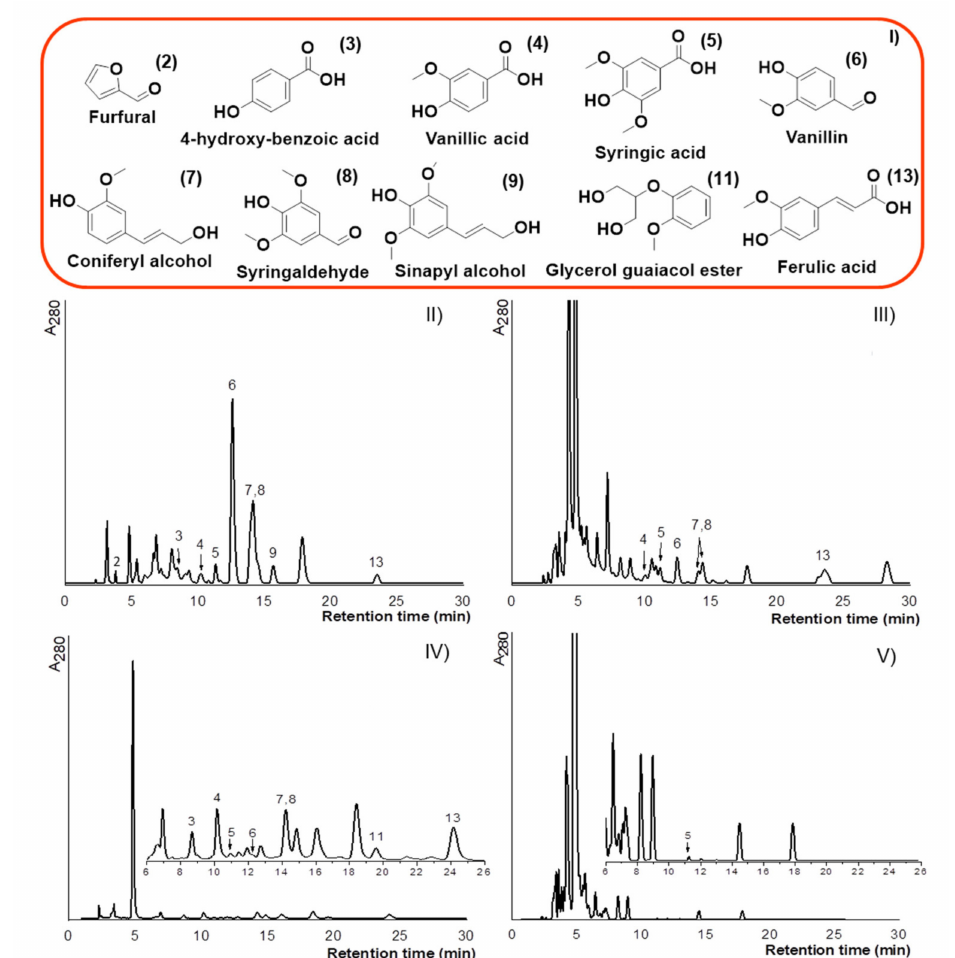
Figure 6. ( I ) Structure of the standards used and HPLC chromatograms of CL LGS -5 ( II ), CL LGS -240 ( III ), W LGS -15 ( IV ) and W LGS -240 ( V